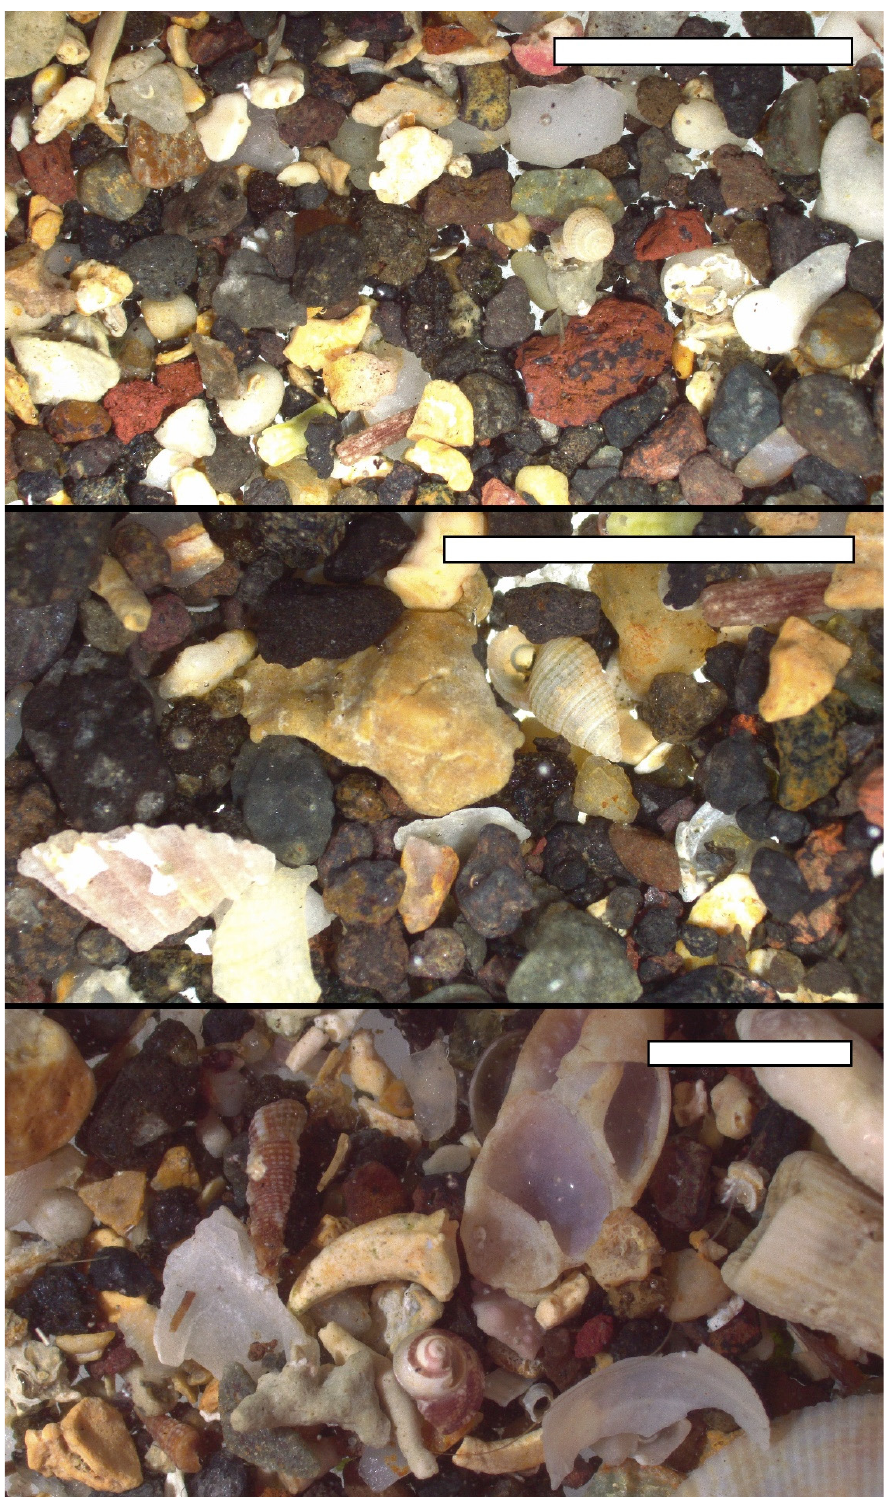
Figure 2. Close up of gravel fraction of the “Amphioxus sand”. Scale bar: 1 cm. Photo credit: Giuseppe Catalano.